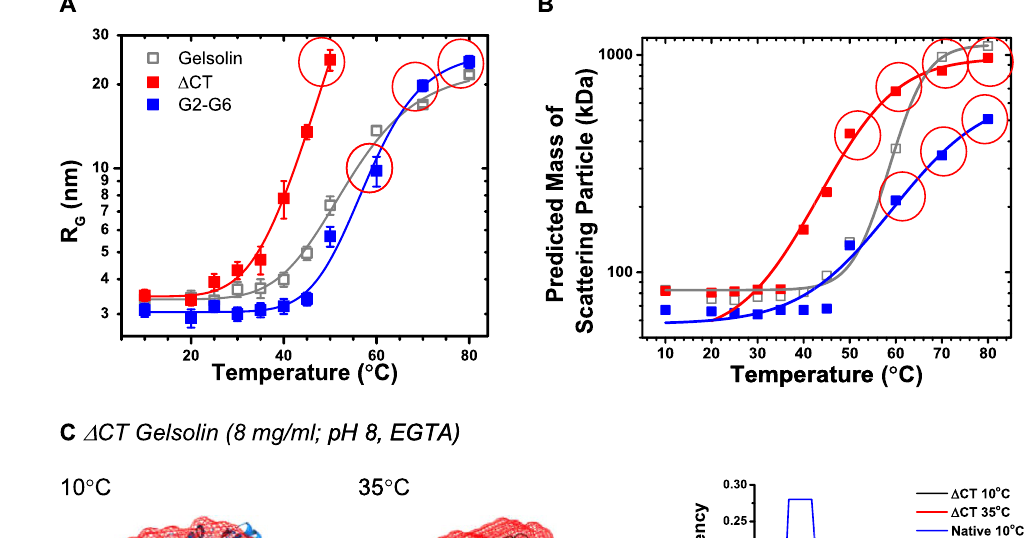
buffer lacking free Ca 2 + ions and having pH 8 was heated to different temperatures and then the temperature was brought back to 10 ° C, while acquiring SAXS data at different temperatures. Guinier analysis provided the R G values of scattering particles which indicated that gelsolin molecules can reversibly close if they are heated up to 40 ° C (Fig. 6A). Samples heated to slightly higher temperatures (45 and 50 ° C) did not show decrement in